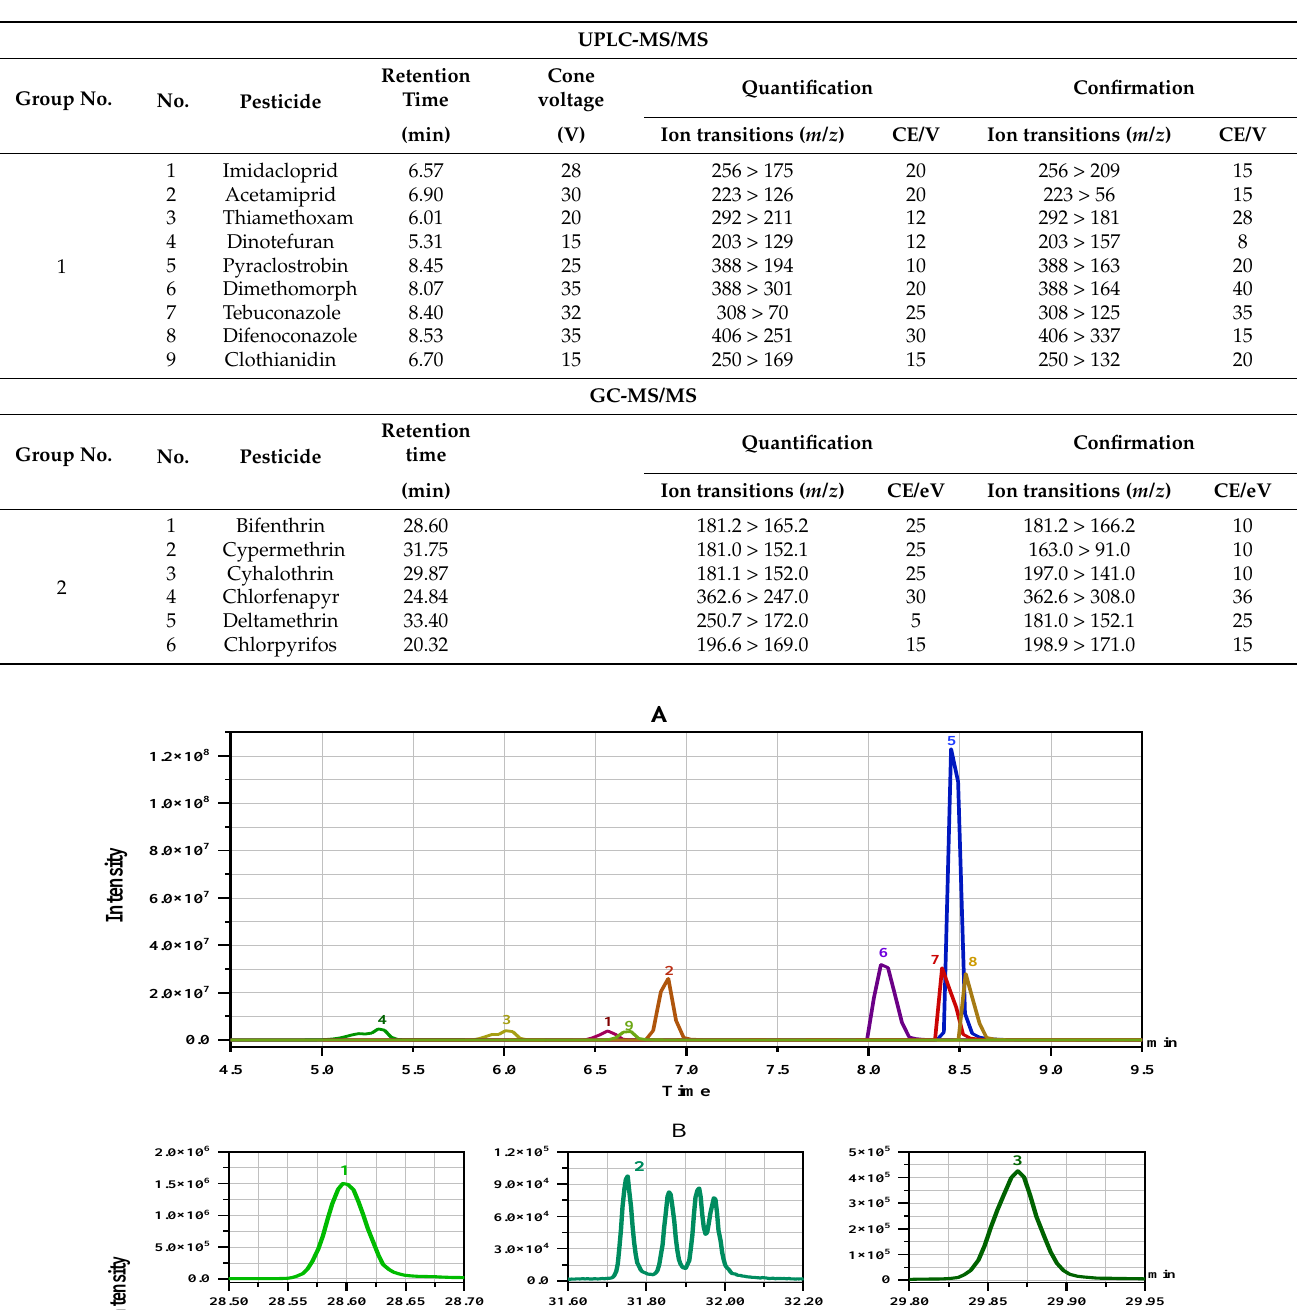
Table 1. The optimised UPLC-MS/MS and GC-MS/MS parameters of Retention time, Cone voltage, Ion transitions and collision energy (CE) for the 15 pesticides.